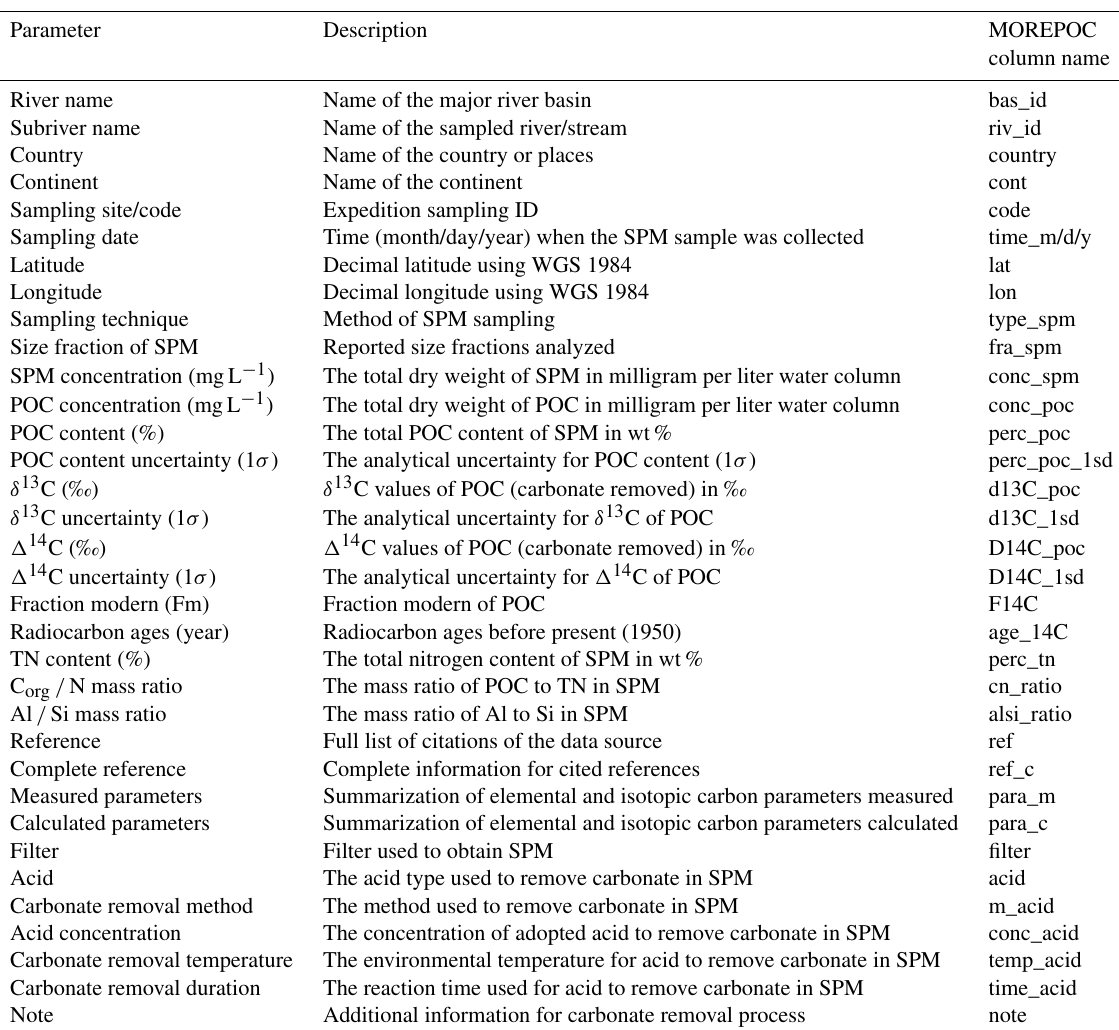
Table 2. Description of the parameters of the MOREPOC v1.1